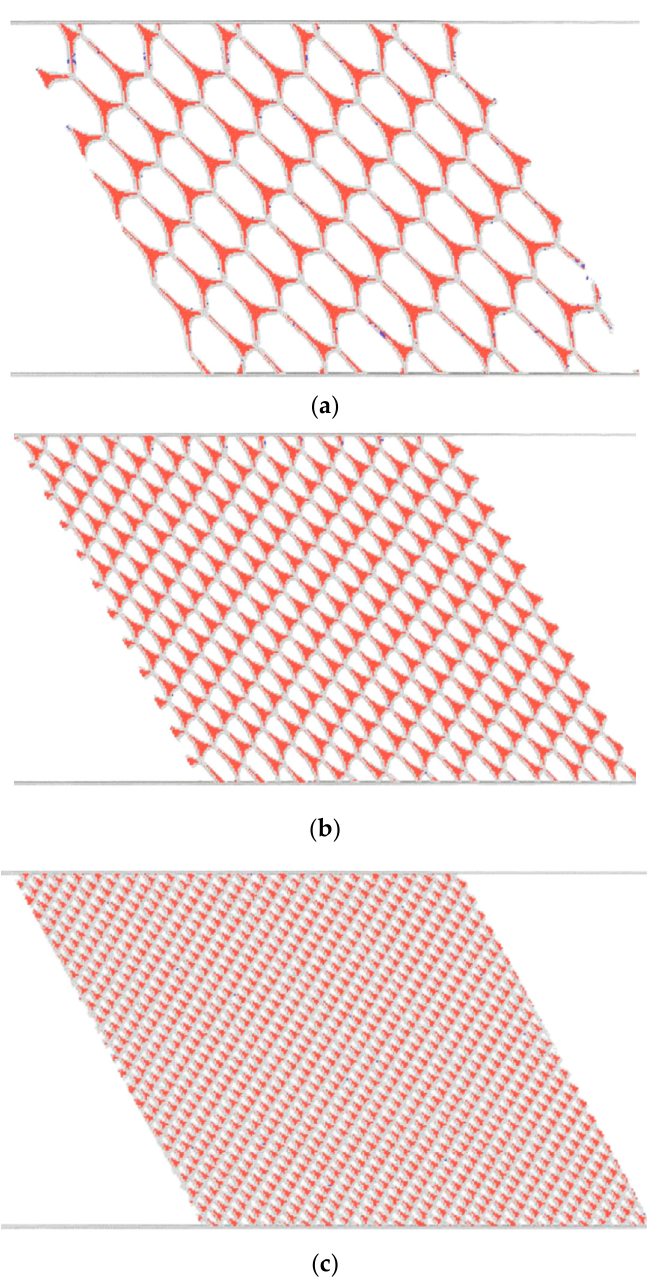
Figure 2. Intrinsic dislocation structure at low angle twist boundaries in Al. The coloring is based on the centrosymmetry (CSM) parameter [33]. Gray lines are dislocation lines, red areas represent stacking faults. ( a ) 2° twist; ( b ) 4° twist; and ( c ) 6° twist.